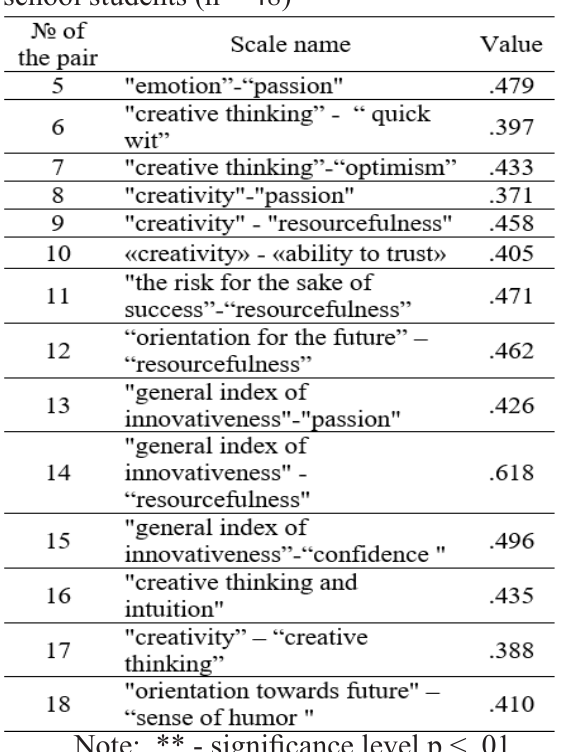
Table 2. The results of rank correlation analysis for all techniques in a group of high Table 3. The indicators of